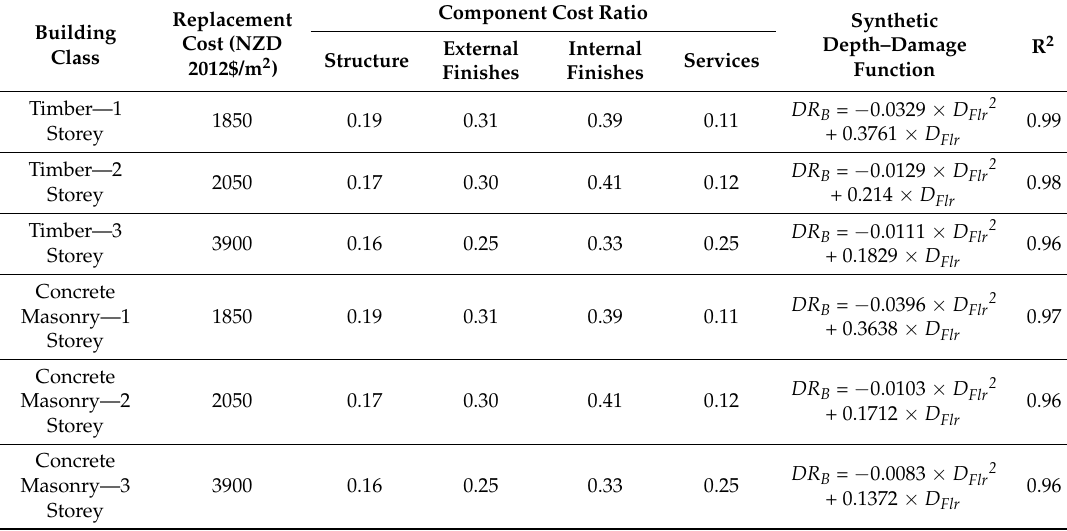
Table 2. Building class replacement costs, component cost ratios and synthetic tsunami depth–damage functions applied in this